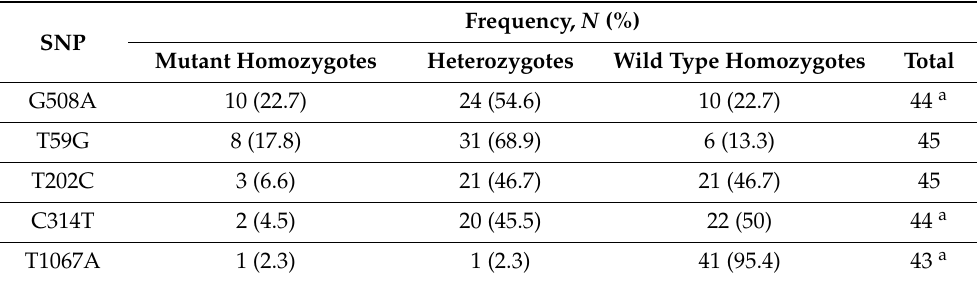
Table 6. Frequencies of polymorphisms on FUT-3 gene in Lewis negative children.